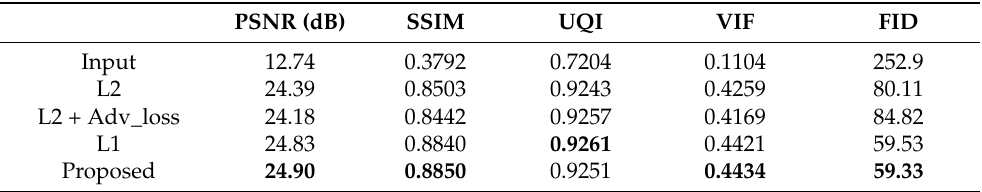
Table 7. Quantitative results for the noise level of sigma 100 compared with different loss functions. Bold results show good scores.